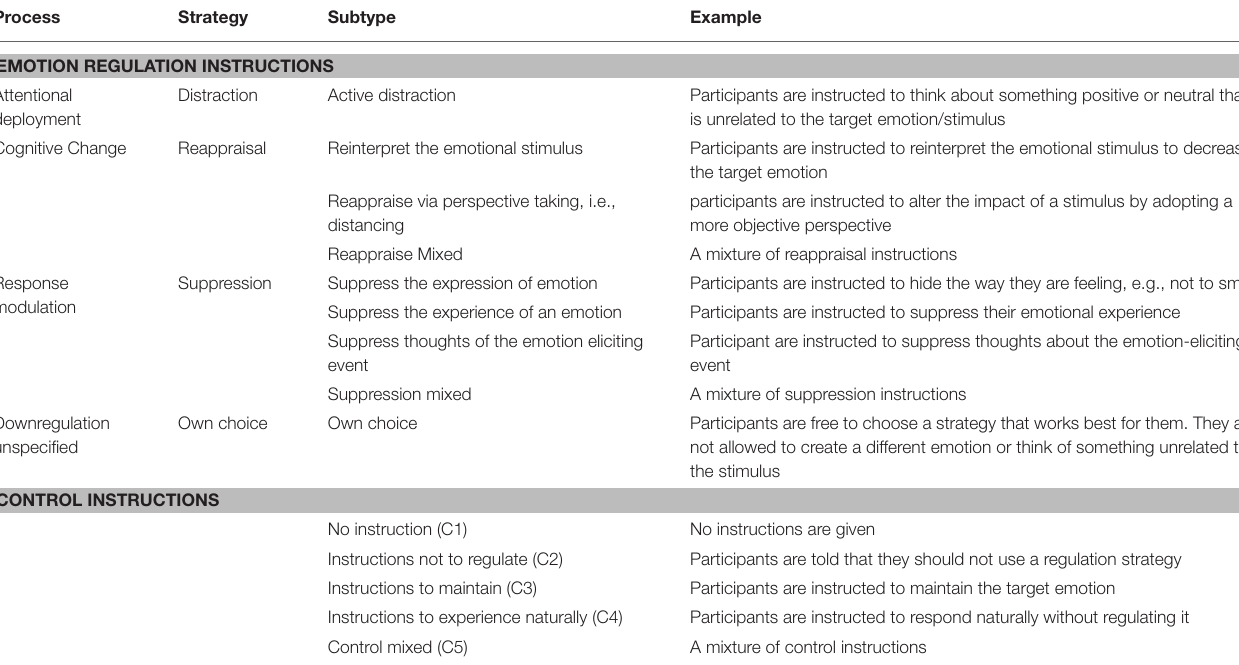
TABLE 1 | Emotion downregulation processes and their strategies considered in this meta-analysis.